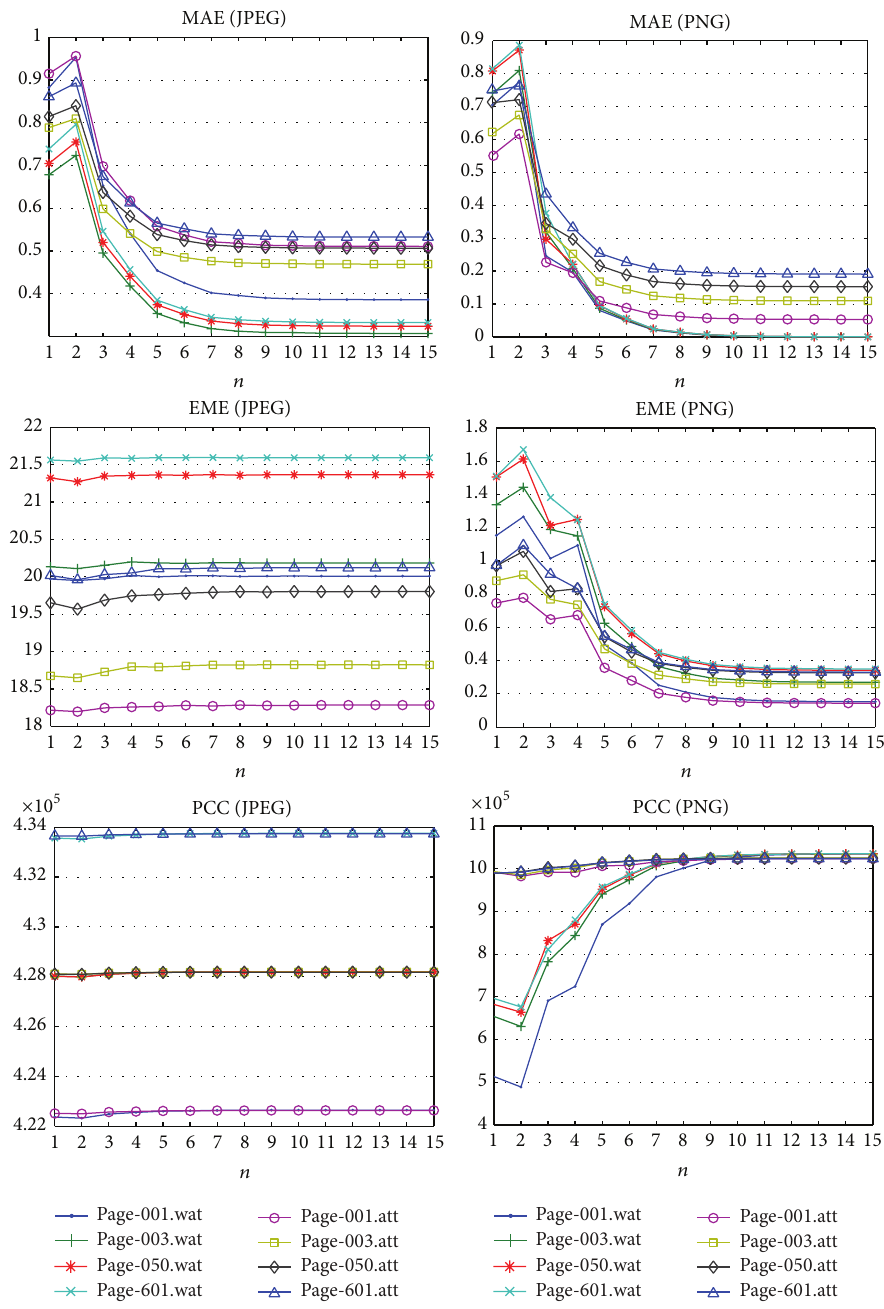
Figure 8: Image quality metrics on Gaussian blurring